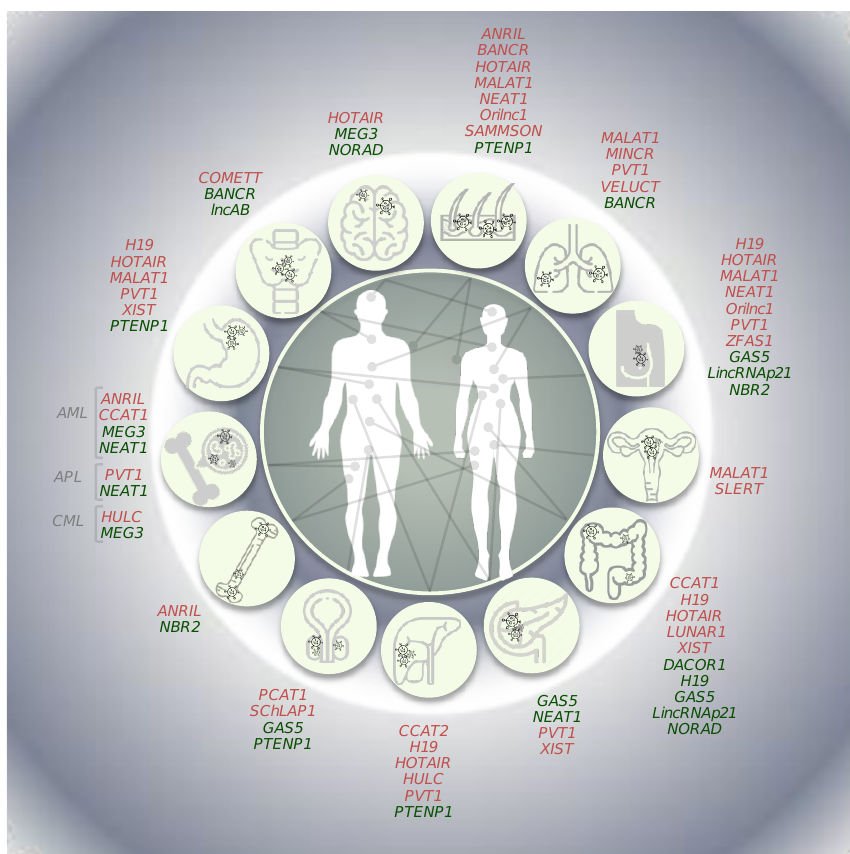
Figure 3. LncRNAs involved in di ff erent cancer types. Main examples of lncRNAs with oncogenic (red) or tumor-suppressive (green) properties reported in di ff erent tumors (i.e., clockwise from top left: neuroblastoma, melanoma, lung c., breast c., ovarian c., colon c., pancreatic c., hepatocellular c., prostate c., osteosarcoma, leukemia, gastric c., papillary thyroid c.). AML = acute myeloid leukemia; APL = acute promyelocytic leukemia; CML = chronic myeloid